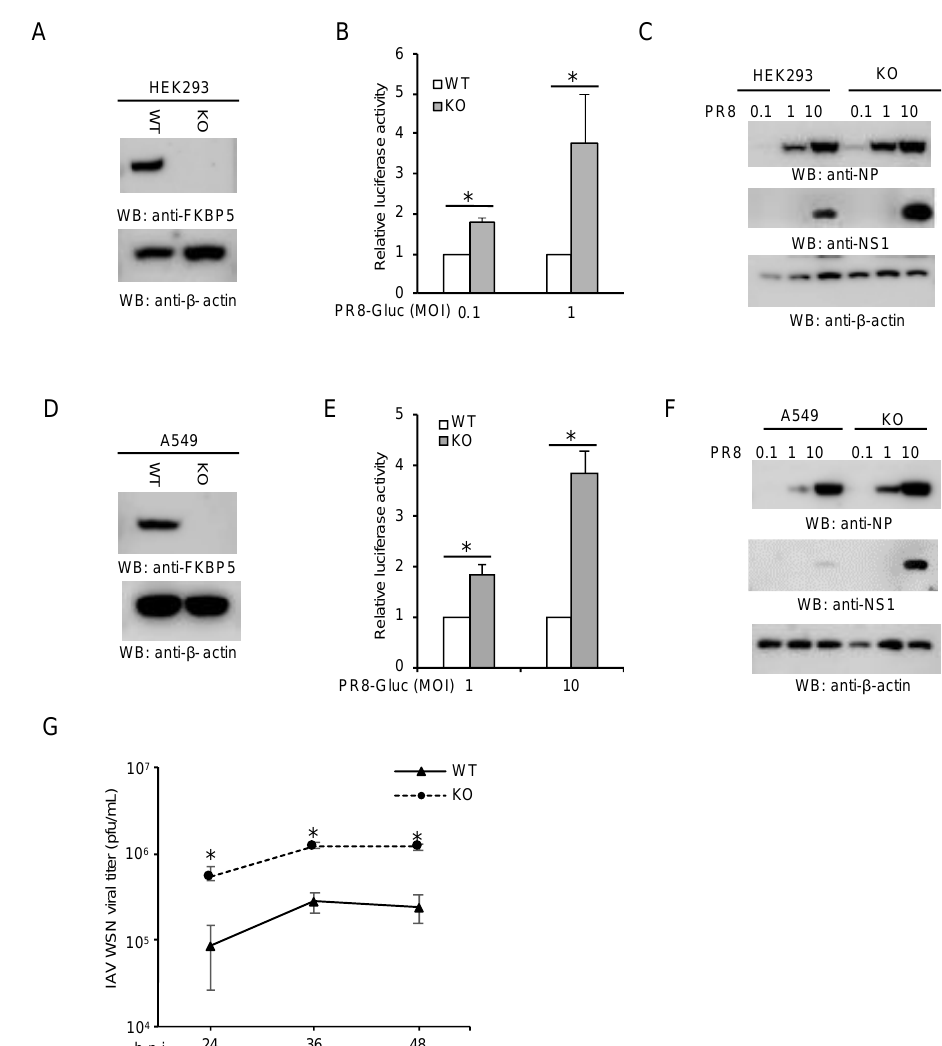
Figure 1. Deficiency of FKBP5 increases host susceptibility to influenza A virus (IAV) infection. ( A ) CRISPR knockout of FKBP5 in HEK293 cells. Cell lysates were blotted as indicated. ( B ) Wild-type (WT) HEK293 and FKBP5 knockout (KO) cells were infected at multiplicity of infection (MOI) of 0.1 or MOI 1 with IAV PR8-Gluc for 24 h. Relative luciferase activities were examined. All experiments were biologically repeated three times. *, p < 0.05. ( C ) FKBP5 wild-type and knockout HEK293 cells were infected with the designated MOI of IAV PR8 for 24 h. Cell lysates were blotted using the indicated antibodies. ( D ) CRISPR knockout of FKBP5 in A549 cells. Cell lysates were blotted as indicated. ( E ) FKBP5 wild-type and knockout A549 cells were infected at MOI of 1 or 10 with IAV PR8-Gluc for 24 h. Relative luciferase activities were examined. All experiments were biologically repeated three times. *, p < 0.05. ( F ) FKBP5 wild-type and knockout A549 cells were infected with the designated MOI of IAV PR8 for 24 h. Cell lysates were blotted using the indicated antibodies. ( G ) Wild-type and FKBP5 knockout A549 cells were infected at an MOI of 0.1 with influenza A / WSN / 1933 (WSN). After the designated hour post-infection (h.p.i.), the virus titers were determined by plaque assay in MDCK cells. All experiments were biologically repeated three times.